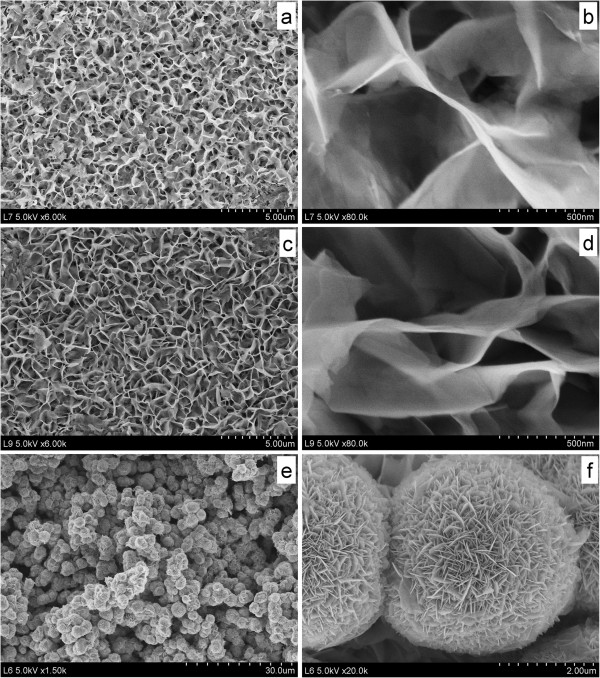
SEM images of CIS layer on TiO2 film, obtained by a solvothermal treatment. At 160°C for 12 h with different InCl3 concentration: (a,b) 0.01 M; (c,d) 0.03 M; (e,f) 0.1 M.